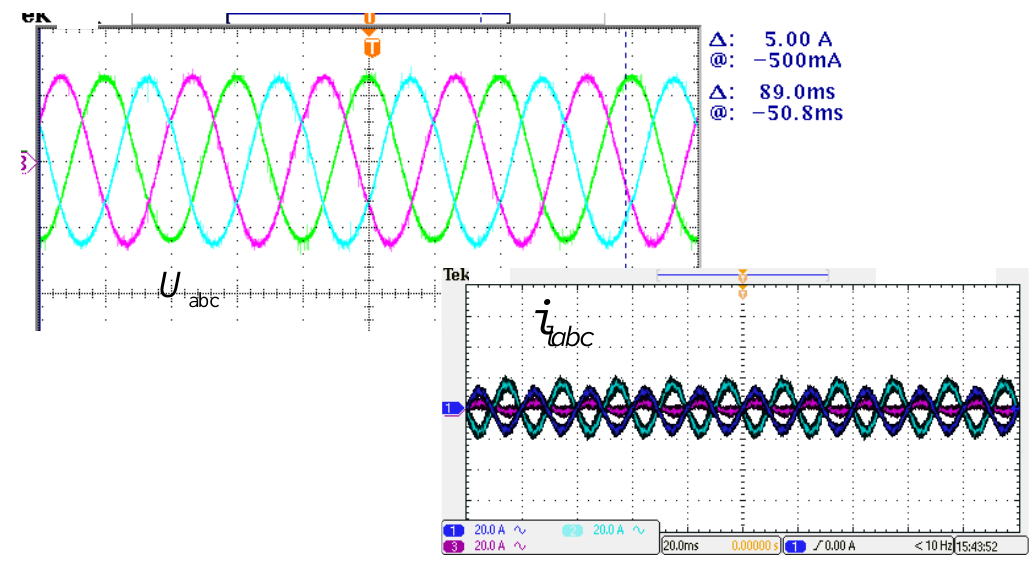
Figure 21. Experimental results of the proposed control strategy with LCO when voltage reference rises to 311